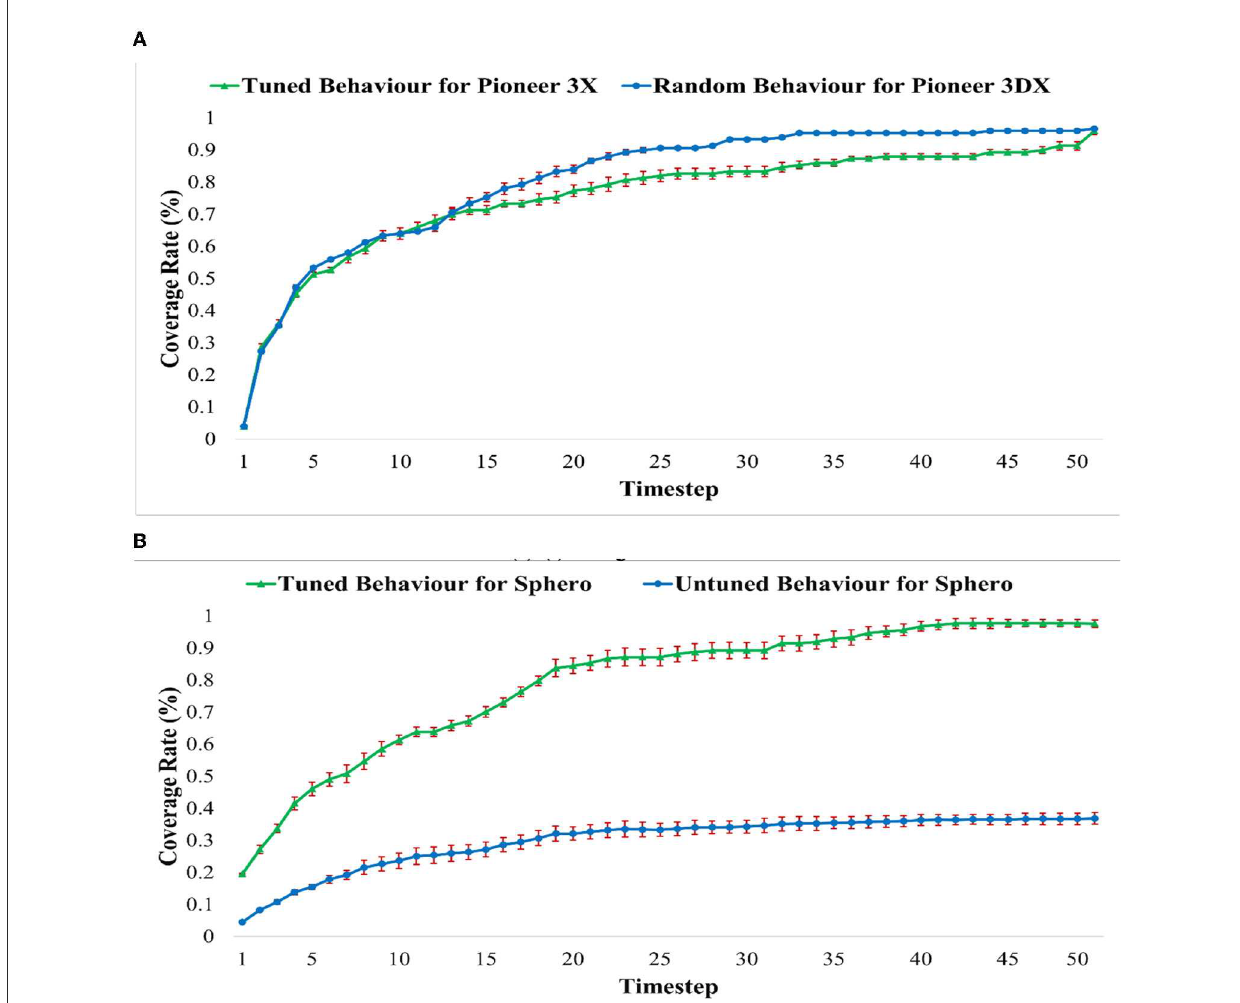
FIGURE12 The coverage rate over time for the tuned behaviors of Figure 10 and random behaviors of Table 1. (A) Average coverage rate of untuned behavior of PR1–PR6 of Table 1 and tuned behaviors of motions (A–F) of Figure 10 for Pioneer3DX Robots. (B) Average coverage rate of untuned behavior of SR1–SR6 of Table 1 and tuned behaviors of motions (G–L) of Figure 10 for Sphero